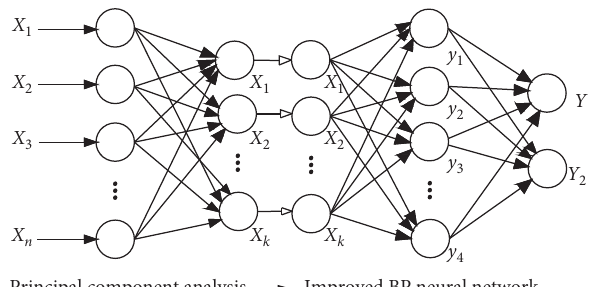
Figure 1: Model structure based on PCA and improved BP neural